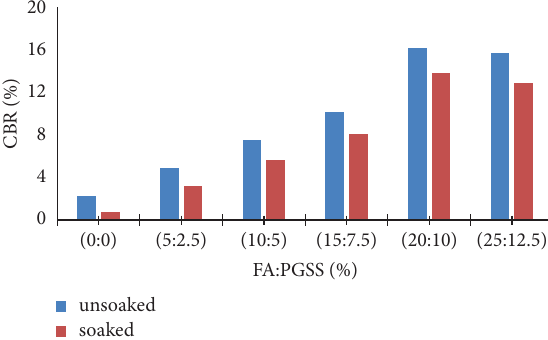
Figure 5: CBR of expansive soil mixed with FA and PGSS.